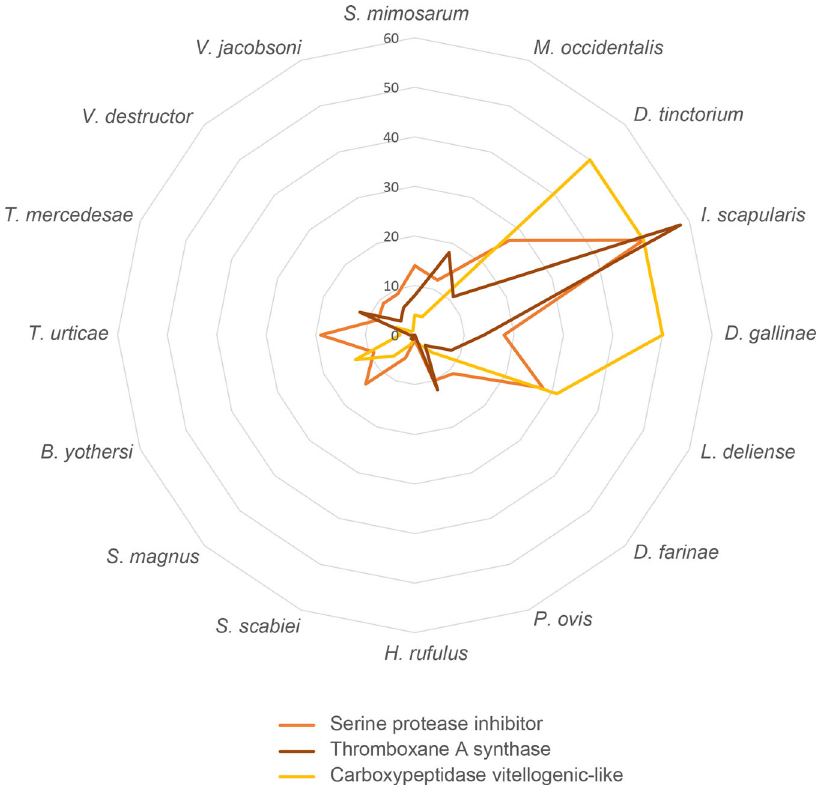
Fig. 5 Gene family expansion in blood-sucking mites. Gene counts related to three haematophagous traits of sixteen